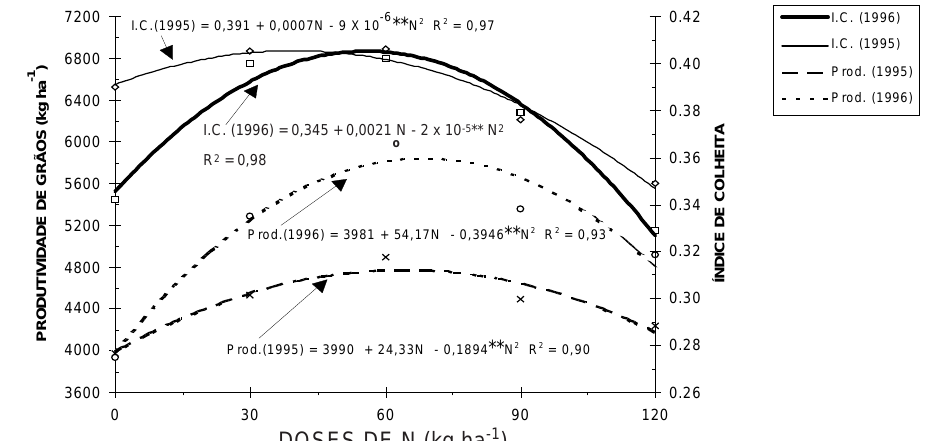
Figura 4. Índice de colheita (I.C.) e produtividade de grãos (Prod.) de trigo influenciados pelas doses de nitrogênio (N) em cobertura, em 1995 e